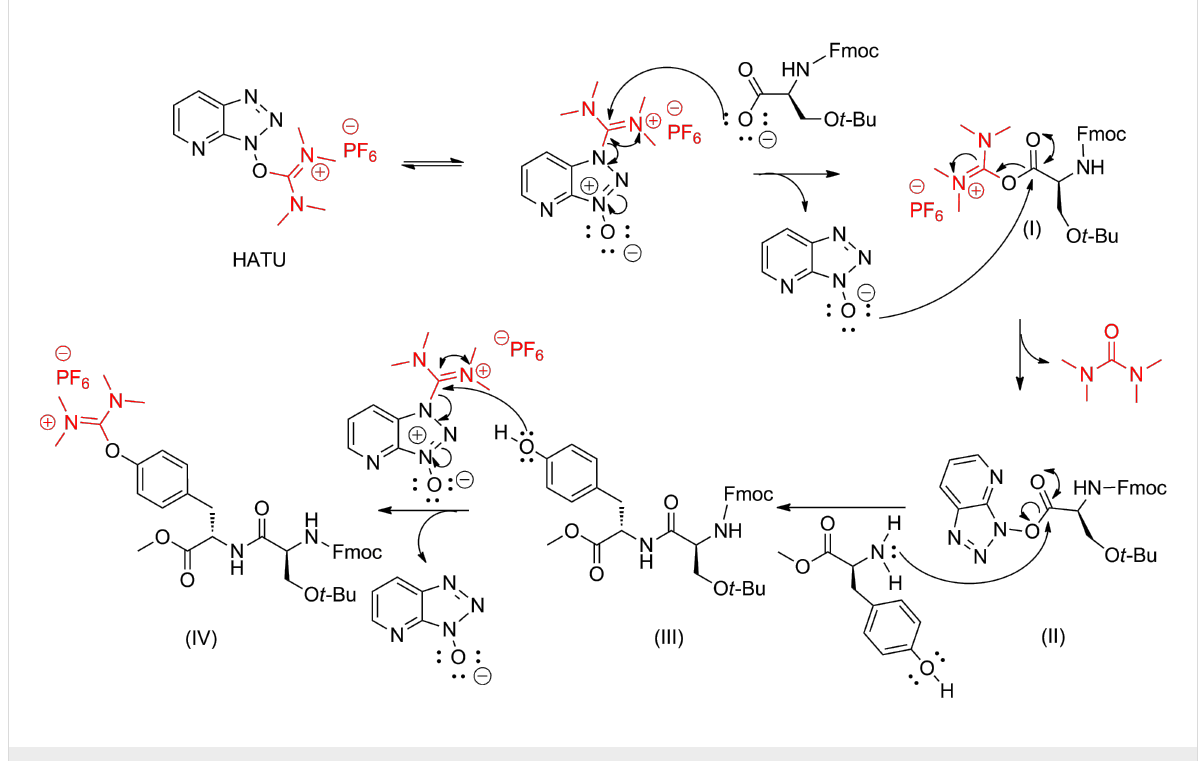
Figure 15: Putative mechanism for the formation of the uronium side product [156].